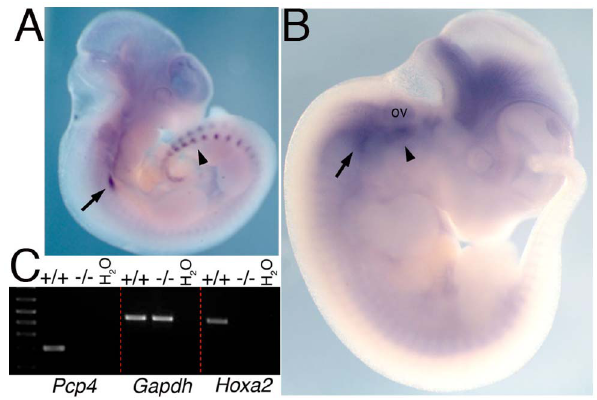
Figure 4. Hoxa2 regulates Pcp4 in the branchial arches. A,B. Whole mount ISH on E10.5 (A) and E11.5 (B) wild-type embryos, using Pcp4 probe. Pcp4 is expressed in the cranial ganglia (arrow, A-B) and dorsal root ganglia (arrowhead in A). One day later Pcp4 expression intensifies in the proximal area of the IIBA (arrowhead in B) in close proximity to the otic vesicle, and in the brain, and caudal expression disappears. C, Semiquantitative RT-PCR in wild type ( + / + ) and Hoxa2 mutant ( 2 / 2 ) E11.5 IIBA cDNA. Pcp4 is expressed in wild type and not Hoxa2 mutant IIBA cells. Gapdh is a positive control gene and Hoxa2 expression is confirmed in wild type and not Hoxa2 mutant IIBA cells. Ov, otic vesicle.